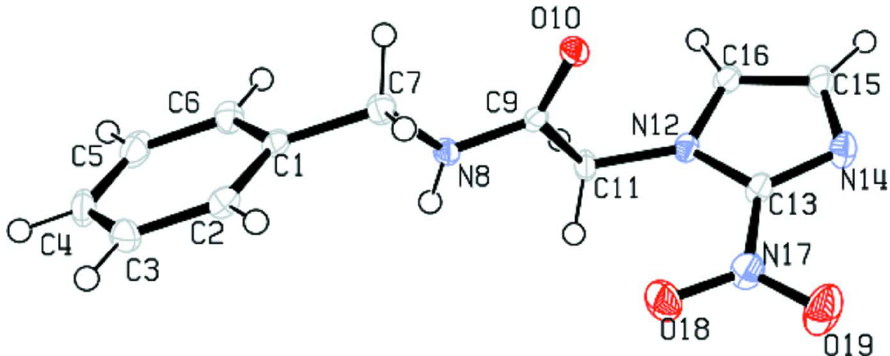
Figure 1 The molecule of Benznidazole showing the atom-labeling scheme. Displacement ellipsoids are drawn at the 50% probability level.